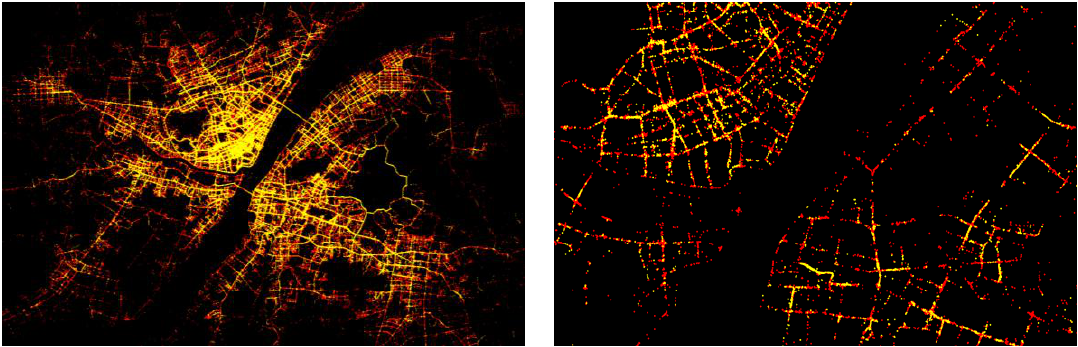
Figure 7. Low-speed (front in yellow) and stop (back in red) GPS points during the time of day on Monday (9 March) ( left panel ) and at 8:00 AM ( right panel